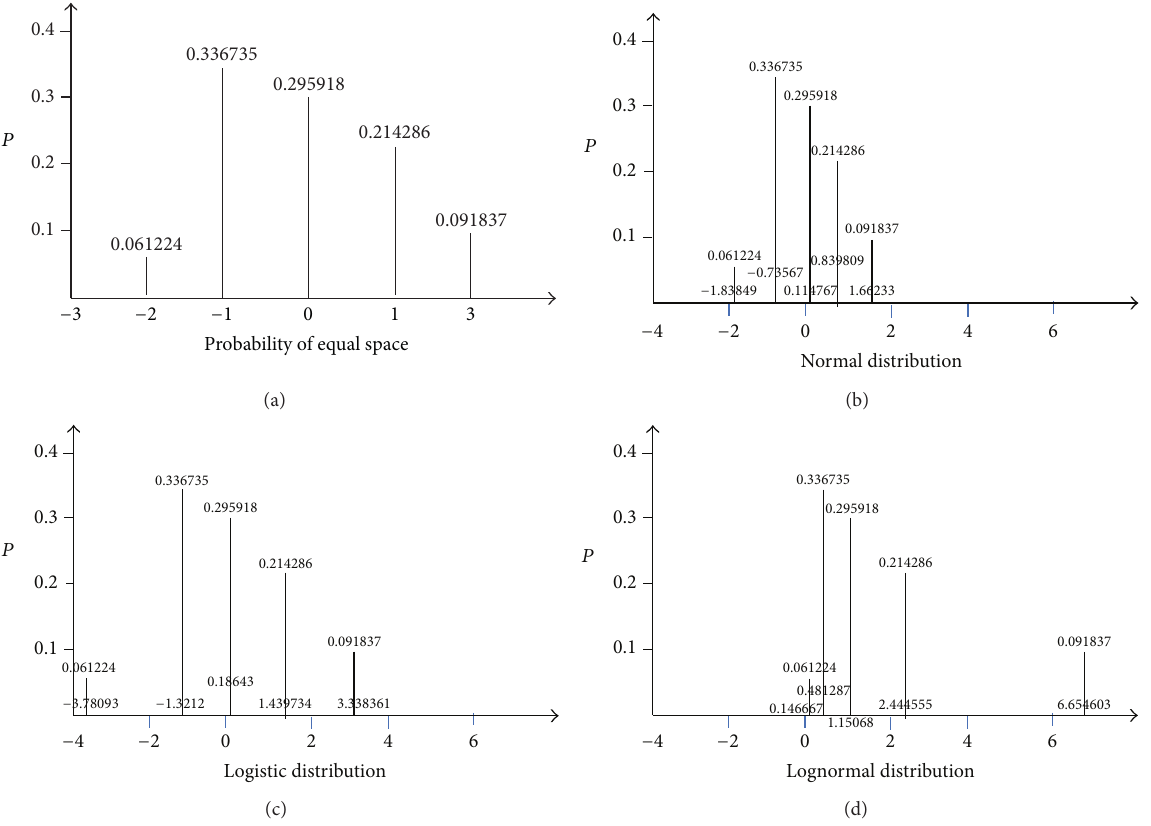
Figure 3: Proability plots comparing the results of scores under the different distributions with the formula of Theorem 1. (a) Equal Space, (b) normal distribution, (c) logistic distribution, and (d) lognormal